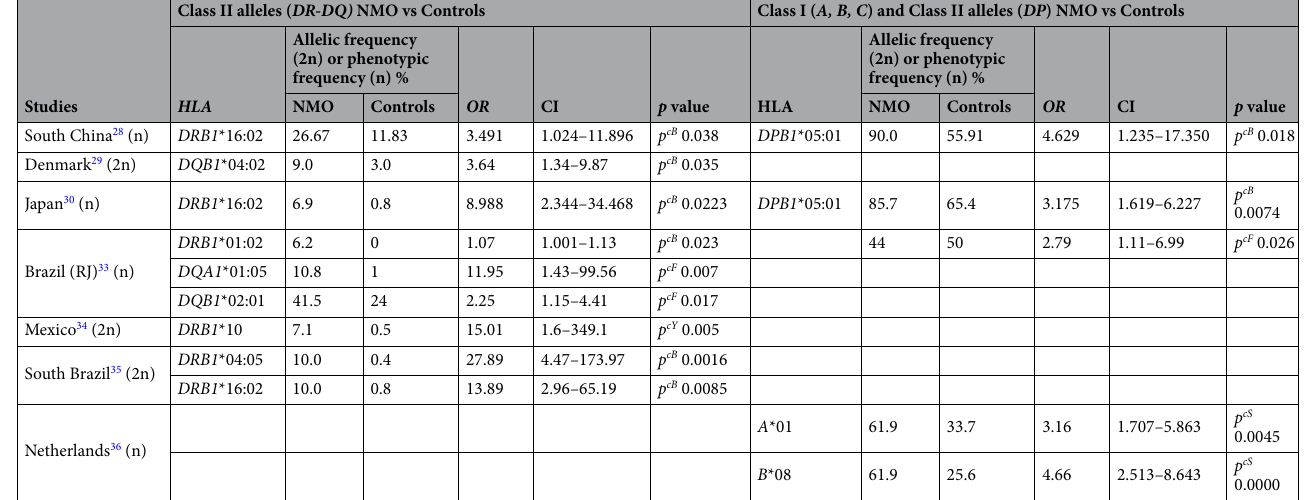
Table 4. Case control studies showing association with NMO of HLA class II alleles (others than DRB1 *03allele group) and HLA class I alleles. NMO, Neuromyelitis Optica; OR , Odds Ratio ; CI, Confidence Interval; p cF , p corrected by Fisher’s exact test; p cB , p corrected by Bonferroni method; p cY , p corrected by Yates method; p cS , corrected by Sidak method; SP, São Paulo; RJ, Rio de